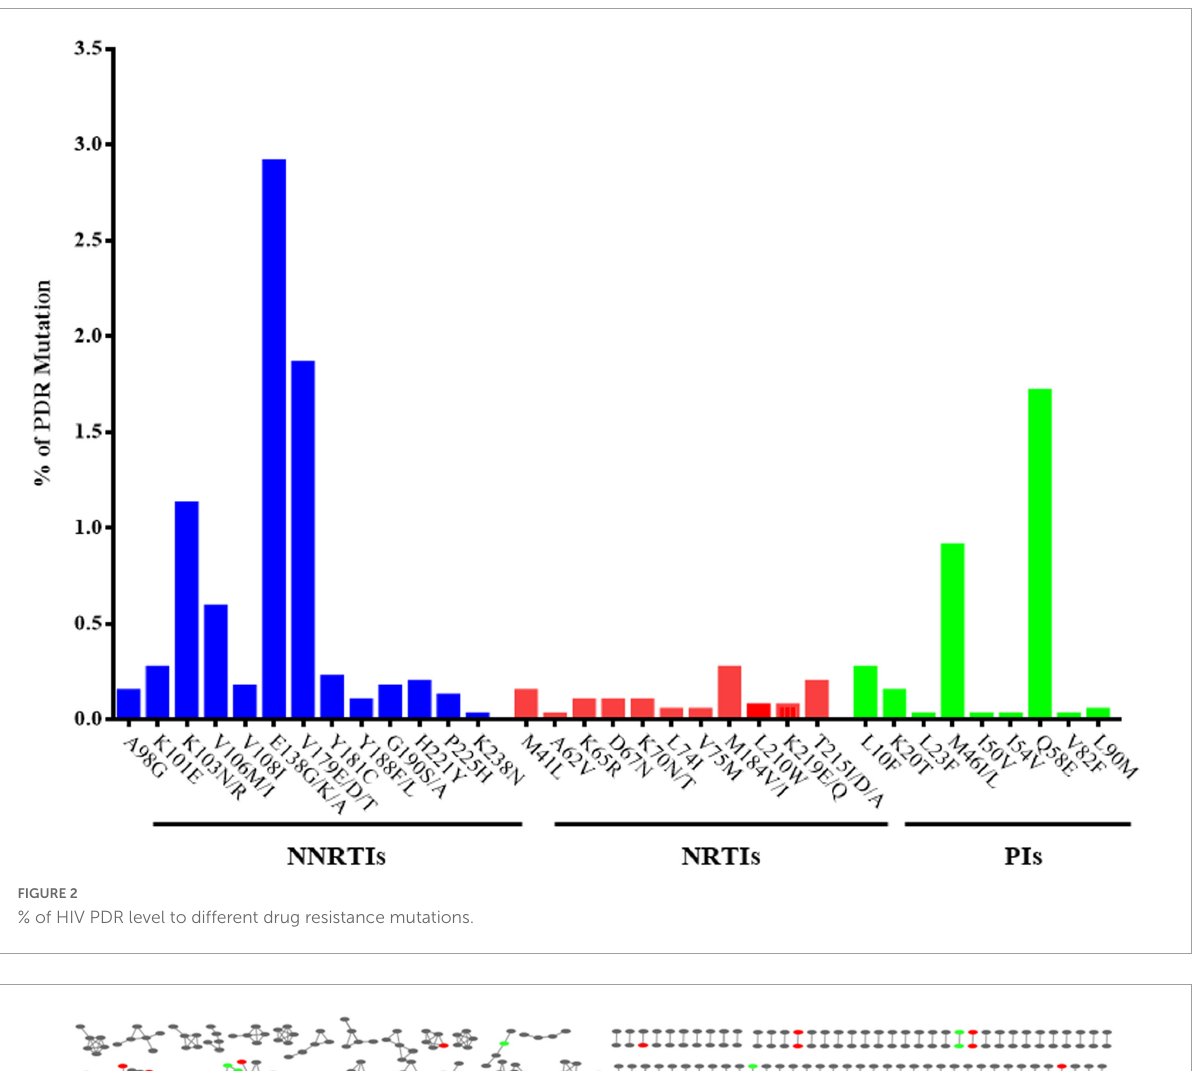
FIGURE2 % of HIV PDR level to different drug resistance mutations.